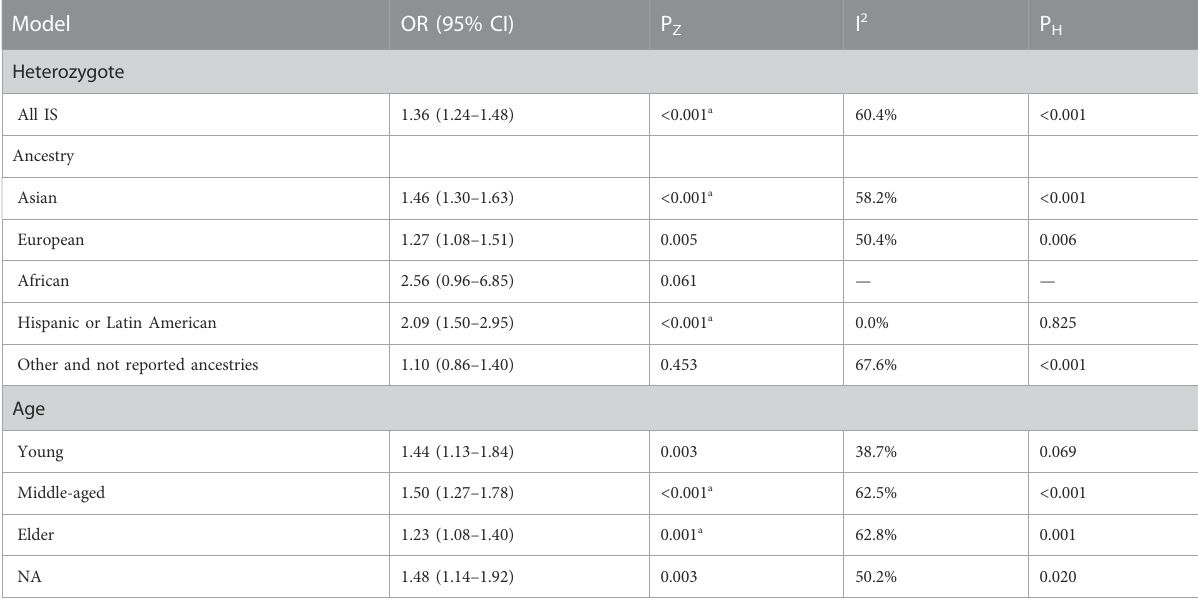
TABLE 4Pooledodds ratios (ORs) and95% con fi denceintervals(CIs) of the association between C677T polymorphismandstroke in the heterozygous model. Model